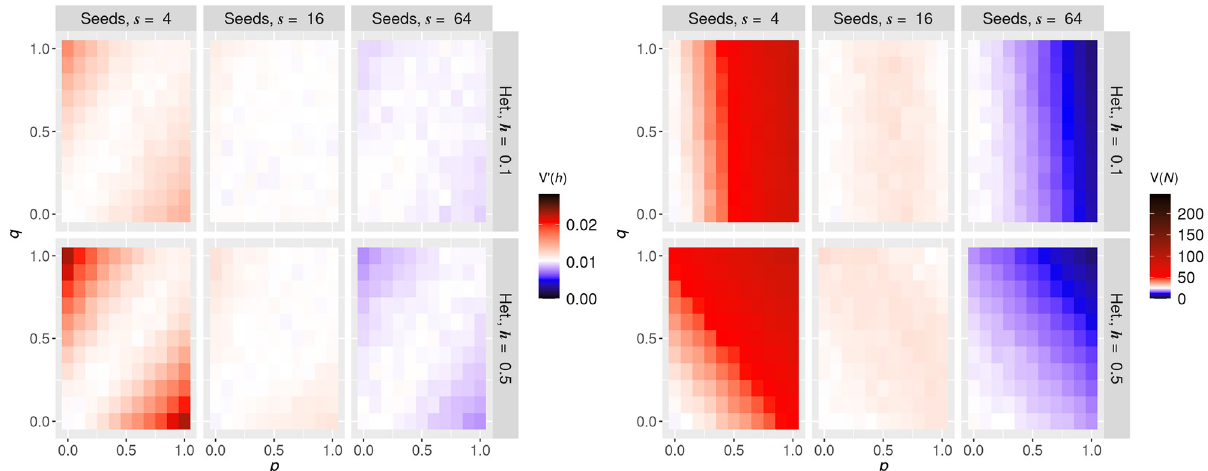
Fig 4. Active spread of mtDNAs in the network can increase and decrease cell-to-cell variability from cell divisions. Simulated normalised heteroplasmy variance V 0 ( h ) (left column) and copy number variance V ( N ) (right column) for mtDNAs with mutual repulsion with radius l = 0.1 within the network, under symmetric cell divisions. Rows show different values of initial mutant proportion, with h = 0.1 in the top row and h = 0.5 in the bottom row. The three columns for each panel give decreasing network heterogeneity, expressed via different seed numbers, 4, 16 and 64 (more seed points give a more homogeneous network). In each panel, variances are given for different values of wild and mutant type network inclusion parameters p (horizontal axis) and q (vertical axis). White baseline reflects the null case from the analytic sum without any network inclusion.